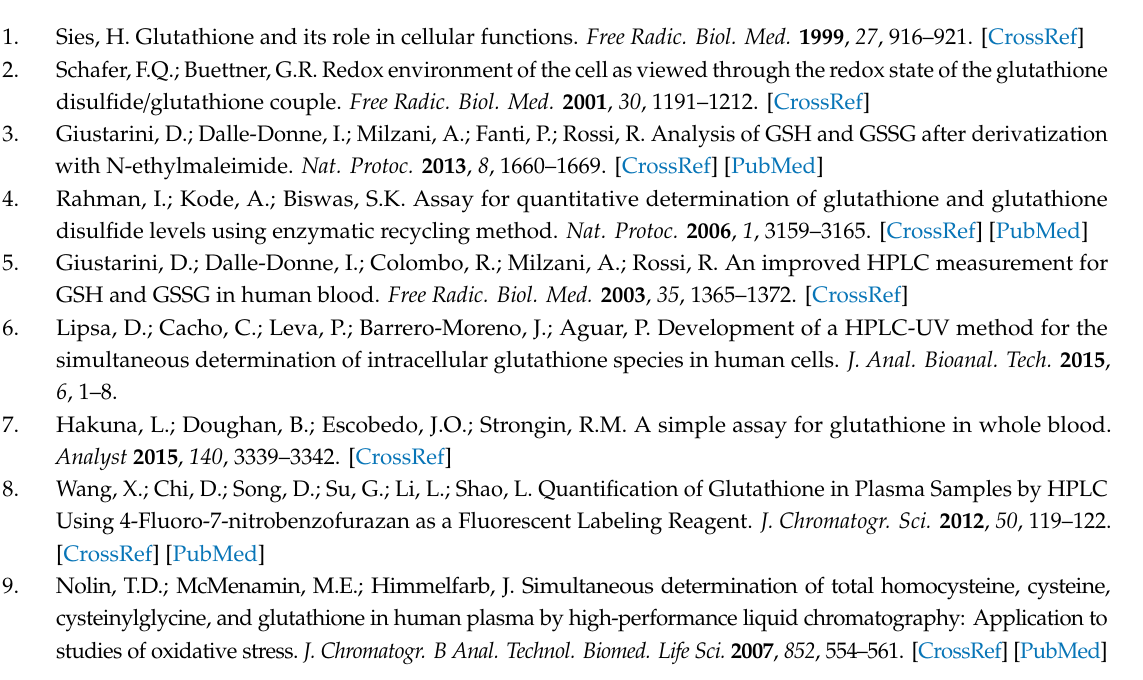
Figure 6. Table S4: GSH and GSSG amounts in LS174T cells with / without H 2 O 2 treatment after normalization to total protein. Data are presented in Figure S9. Table S5: Analysis of variance (ANOVA) of GSH / GSSG ratios between HCT116 cell lines was performed in R (version 3.5.1) with Tukey’s post hoc test. A p -value of less than 0.05 was considered statistically significant. n.s., not significant. Supplementary File